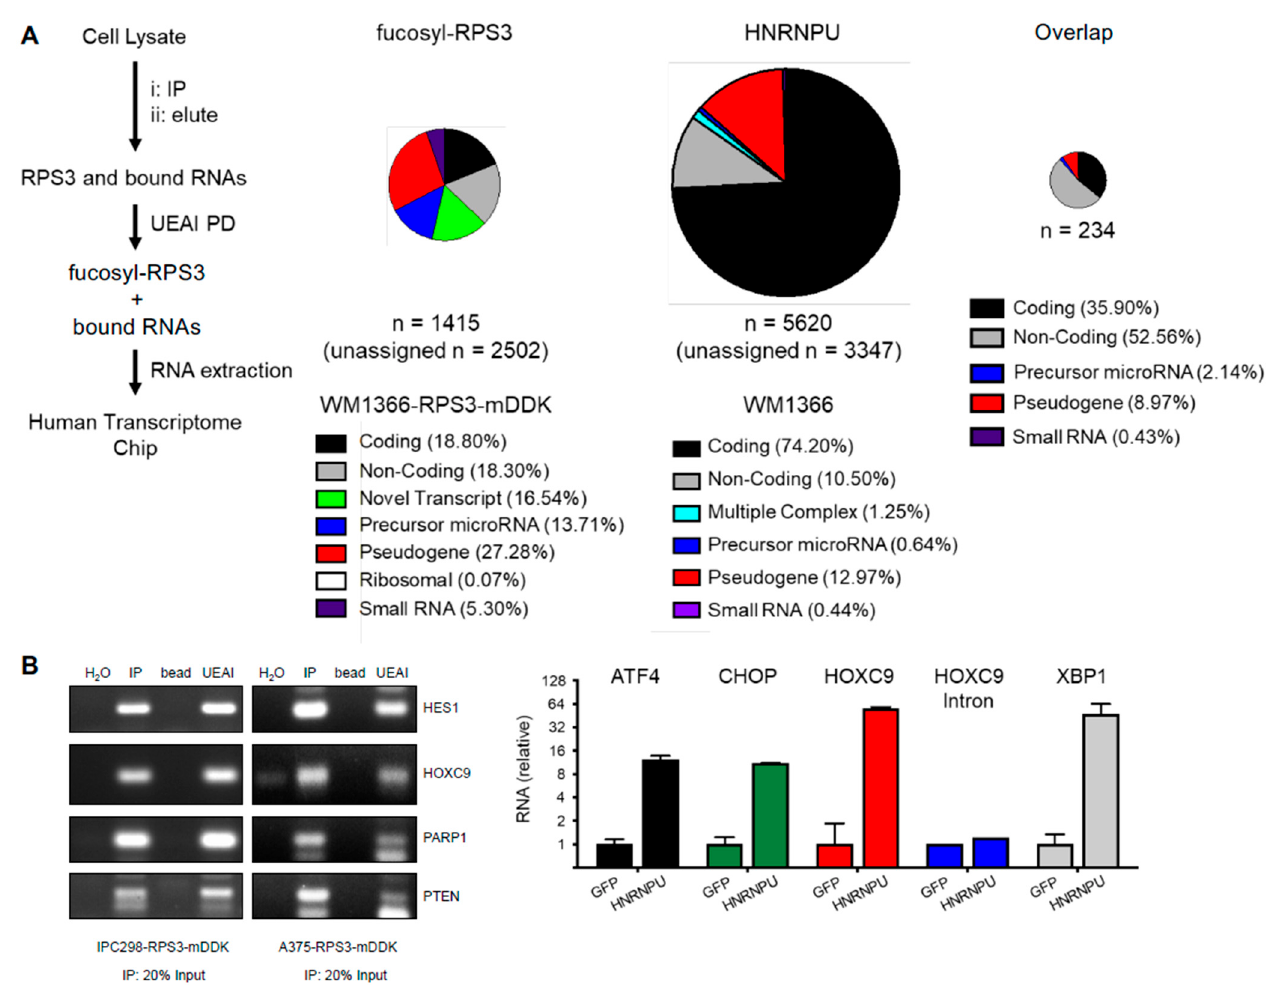
Figure 4. Identification of RNAs that interact with fucosylated RPS3 and HNRNPU. ( A ) Workflow and results for fucosylated RPS3 (fucosyl-RPS3) and HNRNPU RIP-Chip. RNAs isolated by fucosylated RPS3 PD, HNRNPU IP, or IgG control IP were analyzed on